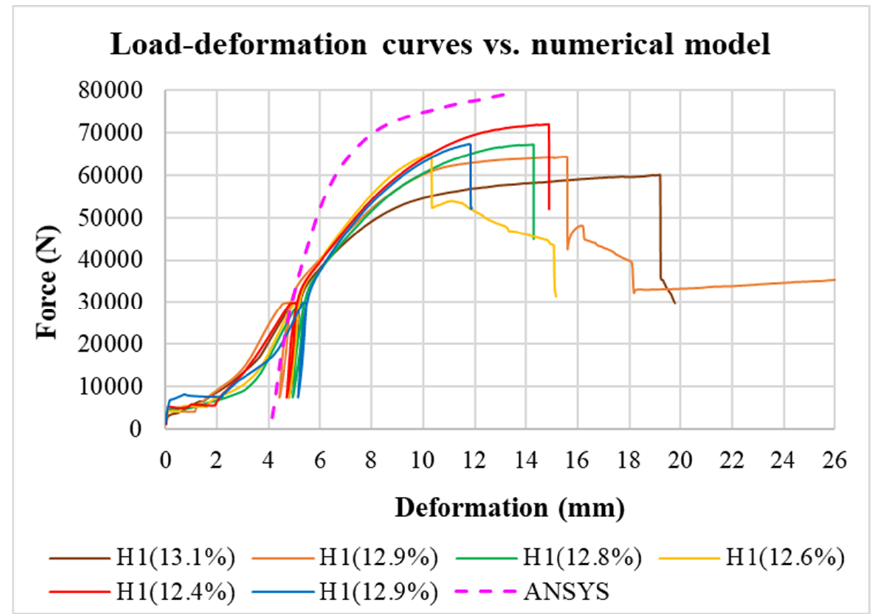
Figure 15. Comparison of real load-deformation curves with the results from the numerical analysis.